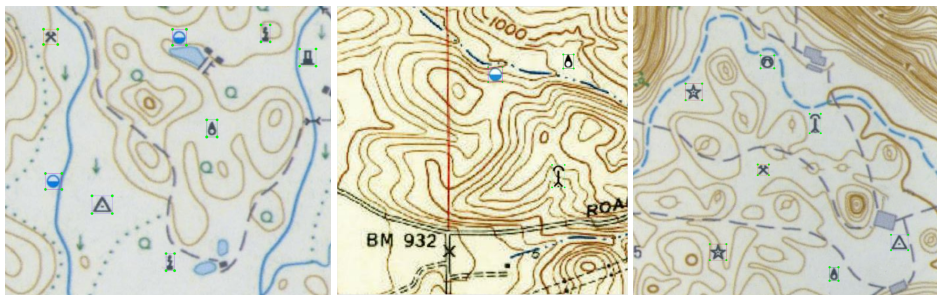
Figure 3. Three annotation samples of the scanned map dataset.